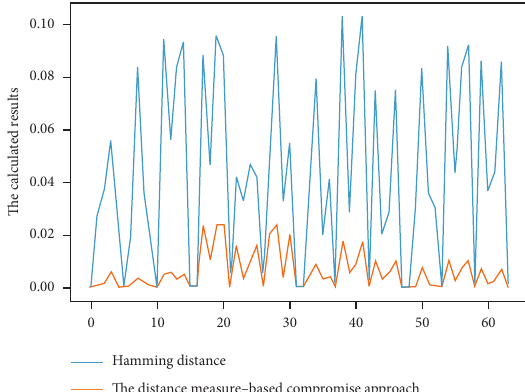
Figure 3: Difference between Hamming distance and compromise